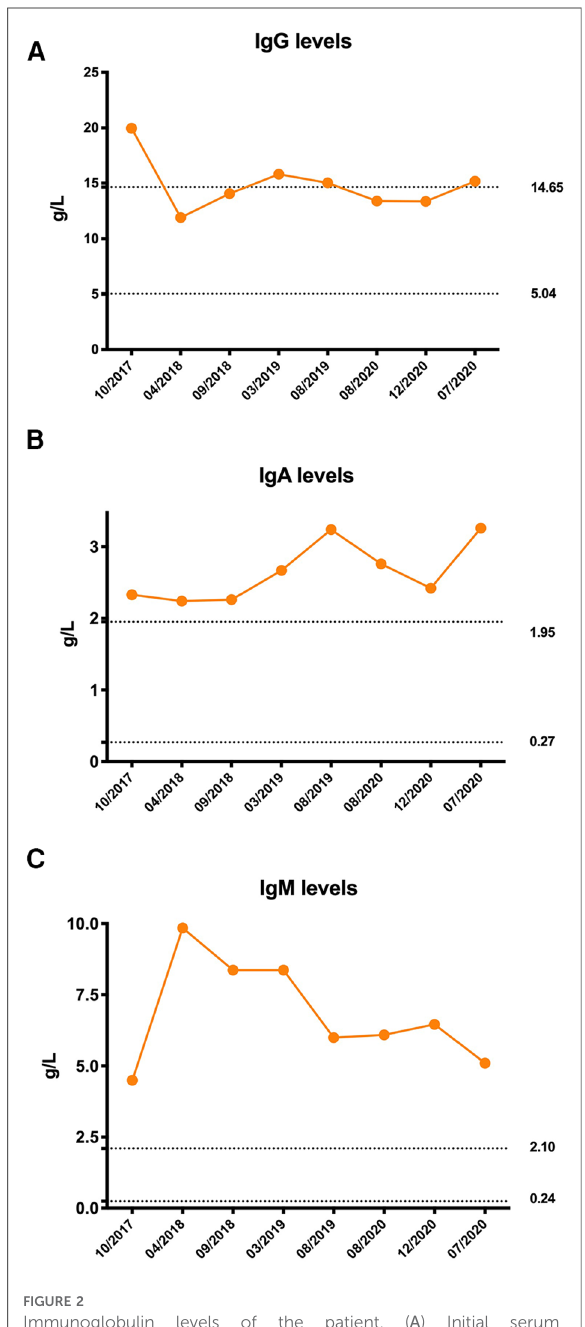
FIGURE 2 Immunoglobulin levels of the patient. ( A ) Initial serum immunoglobulin G (IgG) level was signi fi cantly elevated and remained at the upper limit of normal after treatment. ( B ) Serum immunoglobulin A (IgA) levels were persistently higher than normal. ( C ) Serum immunoglobulin M (IgM) levels were persistently higher than normal. The dotted line was the normal reference value.